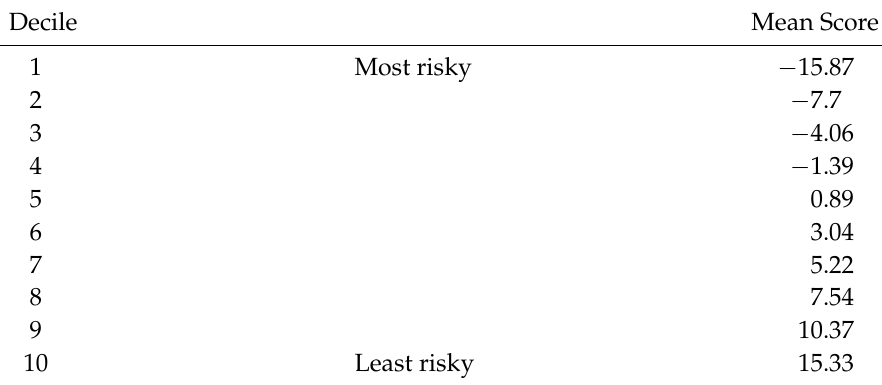
Table 2: Mean Scores for the Individual–Major Match by